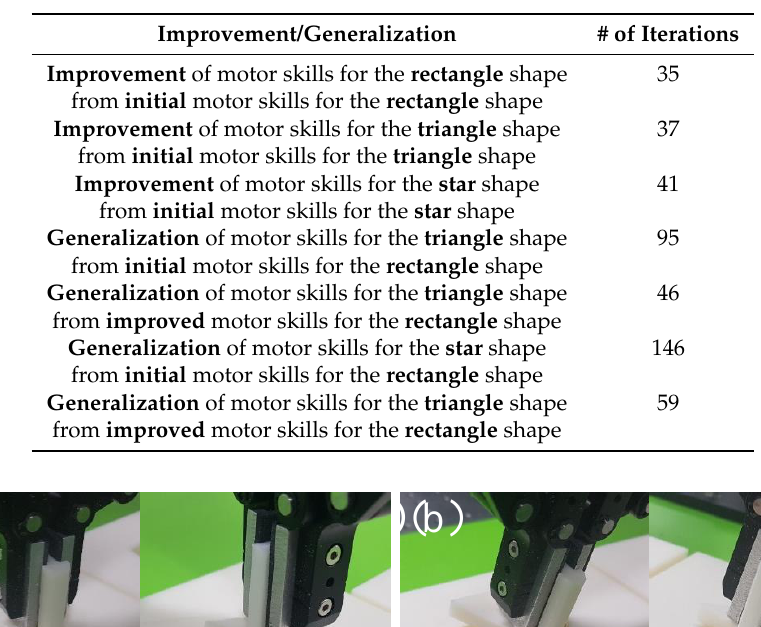
Figure 10. Using motor skills learned from the rectangle shape for different shapes: ( a ) pentagon; ( b ) hexagon; ( c ) triangle; and ( d ) star. These figures indicate the successful cases in which the motor skills learned for the rectangle shape can be used for other shapes without any generalization process. Table 3. Comparison of number of iterations used in the improvement and generalization processes.